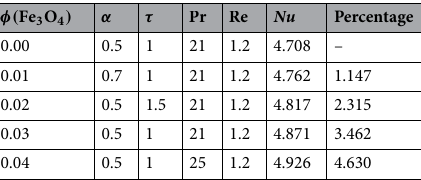
Table 4. Percentage enhancement for different volume fraction of Fe 3 O 4 .